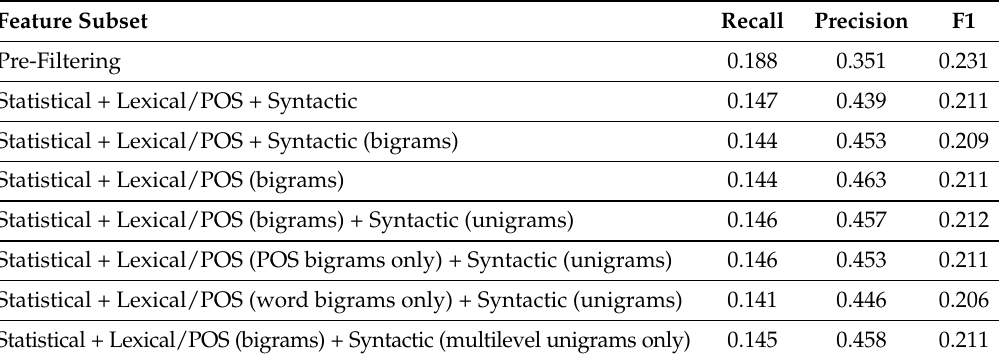
Table 8. Average evaluation obtained by the participating systems using the TAC KBP 2013 Slot Filling scorer on the test dataset after filtering when using different feature